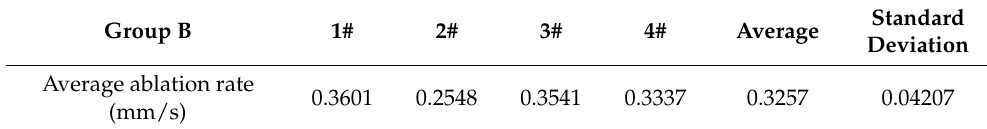
Table 5. Ablation rate of Group B in whole process (gas phase velocity was 30